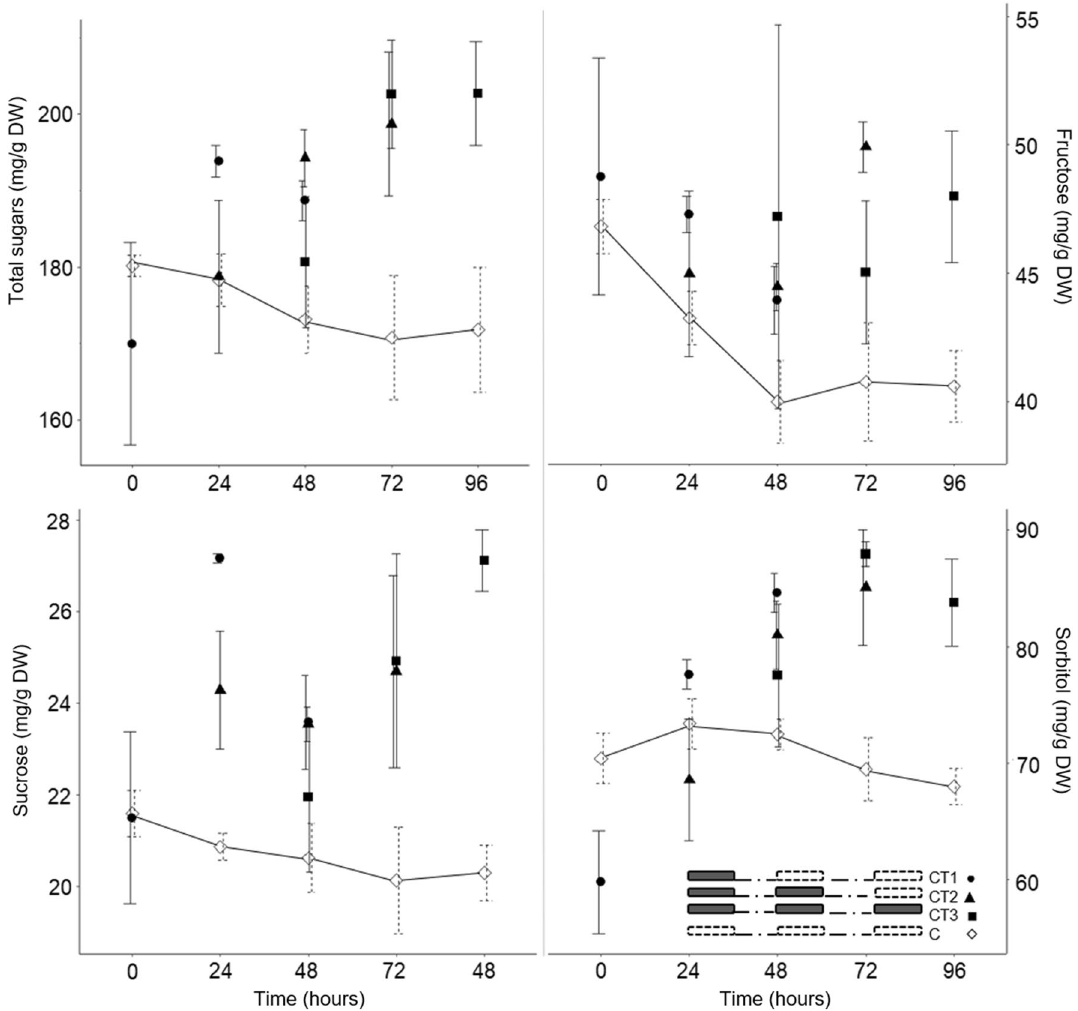
Figure 4. The total sugars, fructose, sucrose and sorbitol content in leaves of ‘Grace Star’ sampled at time 0, time 24, time 48, time 72 and time 96 in Experiment II. Vertical bars represent ± SE of the mean (n = 3; n = 3, 6 or 9 for controls). For other bar details, see Fig.